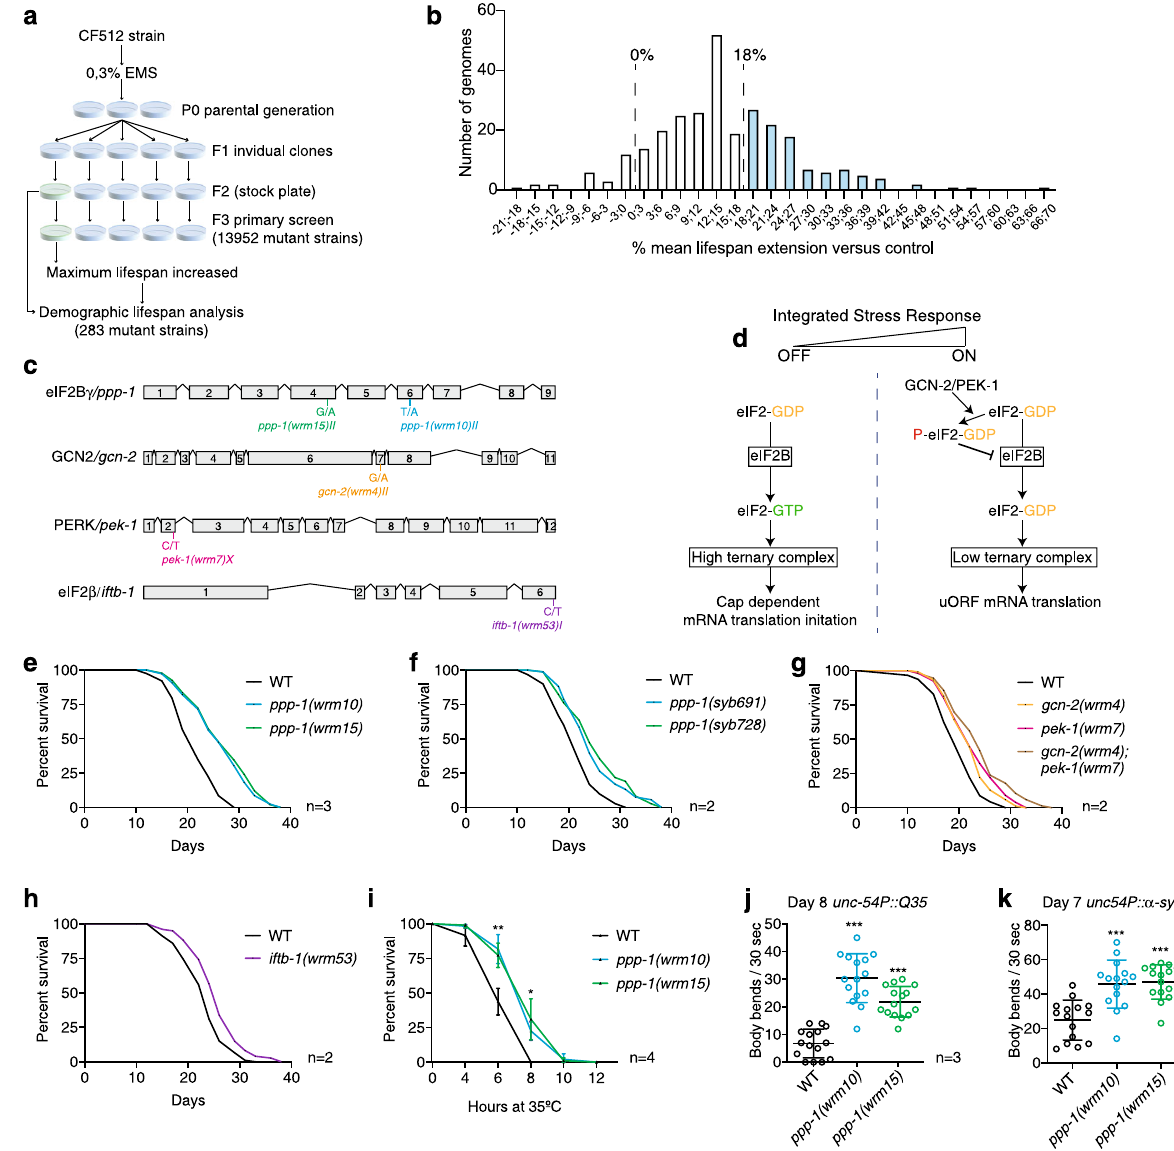
Fig. 1 Unbiased forward longevity screen in C. elegans identi fi es mutations in ISR components. a Mutagenesis screening strategy. b Mean lifespan extension (normalized to temperature-sensitive sterile CF512 control) visualized as the number of tested genomes in 3% bins. c Schematic representation of identi fi ed ISR genes and corresponding longevity alleles. d Cartoon depiction of mRNA translation initiation and the ISR. e Survival of outcrossed ppp-1 ( wrm10 ) and ppp-1 ( wrm15 ) mutants compared to WT controls (representative data from n = 3 independent experiments). f Survival of CRISPR/Cas9- generated ppp-1 alleles syb691 and syb728 compared to WT controls (representative data from n = 2 independent experiments). syb691 corresponds to wrm10 and syb728 to wrm15. g Survival of outcrossed gcn-2(wrm4) , pek-1(wrm7) , and gcn-2(wrm4); pek-1(wrm7) double mutants compared to WT controls (representative data from n = 2 independent experiments). h Survival of outcrossed iftb-1(wrm53) mutants compared to WT controls (representative data from n = 2 independent experiments). i Thermotolerance assays of day 1 ppp-1 mutant worms compared to WT controls (error bars represent means ± SD, two-way ANOVA Dunnett ’ s post hoc test with ** p = 0.0032 ppp-1(wrm10) vs. WT at the 6 h time point; ** p = 0.0039 ppp-1(wrm15) vs WT at the 6 h time point; * p = 0.0107 ppp-1(wrm10) vs. WT at the 8 h time point; * p = 0.0404 ppp-1(wrm15) vs. WT at the 8 h time point; n = 4 independent experiments with 50 animals each). j Motility assay using day 8 WT animals and ppp-1 mutants with an unc-54P -driven muscle-speci fi c expression of polyQ35 – YFP fusion protein (error bars represent means ± SD, one-way ANOVA Dunnett ’ s post hoc test with *** p < 0.001 vs. WT controls; n = 3 independent experiments with ≥ 12 animals each). k Motility assay using day 7 WT animals and ppp-1 mutants with an unc-54P -driven muscle-speci fi c expression of α -synuclein (error bars represent means± SD, one-way ANOVA Dunnett ’ s post hoc test with *** p < 0.001 vs. WT controls; n = 3 independent experiments with 15 worms each). See Supplementary Dataset 1 for survival statistics. See Supplementary Table 1 for statistics on thermotolerance assays. Source data are provided as a Source Data fi